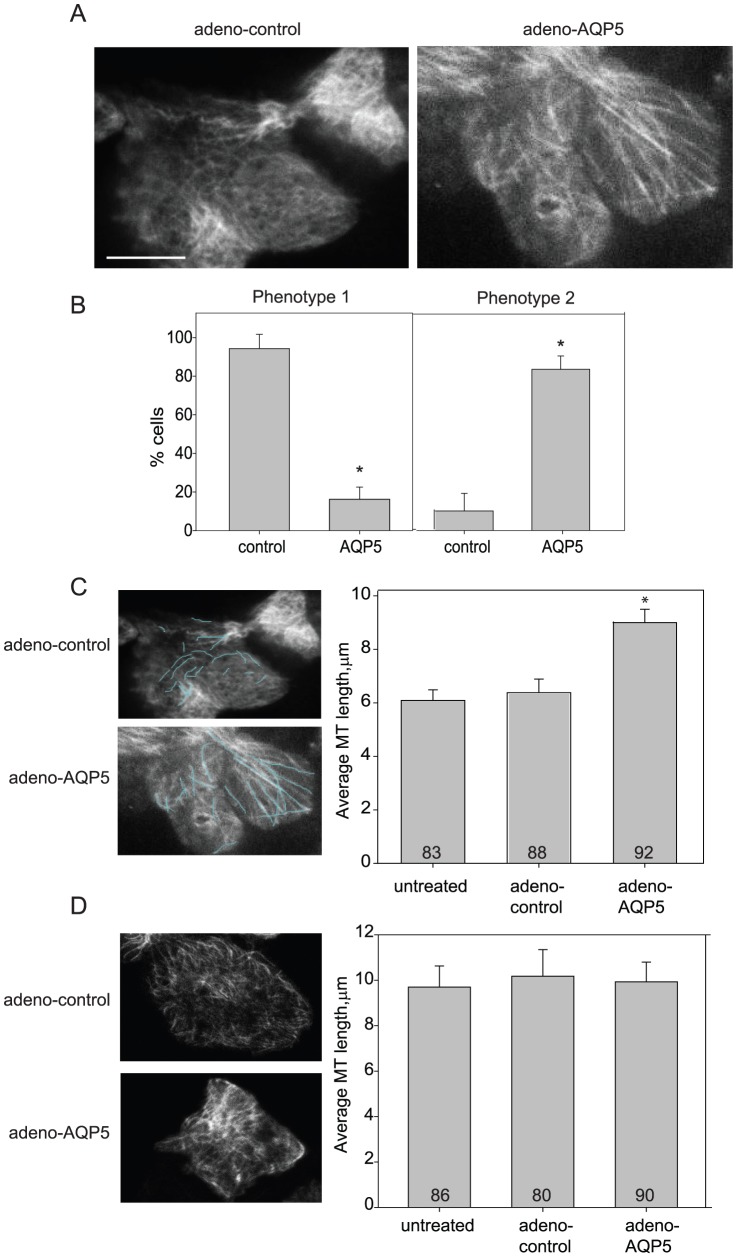
Total internal reflection fluorescence (TIRF) imaging showed that AQP5 altered MT structure at apical surfaces.A. Cells transduced with control adenoviruses (adeno-control) show a MT meshwork at their apical surfaces. Cells expressing AQP5 (adeno-AQP5) had longer, more aligned MTs at their apical surfaces. Scale bar, 10 µm. B. Cells expressing AQP5 were significantly more likely to have long and straight apical MTs. MT phenotypes were grouped into two categories, phenotype 1 (panel A, adeno control (n=22 cells) image is an example) and phenotype 2 (panel A, adeno-AQP5 (n=20 cells) image is an example). Cells within each treatment group were sorted based on image appearance. The frequency of cells that had either phenotype for each condition is plotted on the bar graphs. The two groups were significantly different (Comparison of Proportions (CP): z=4.6; p<0.0001). C. Cells expressing AQP5 had longer apical MTs than control cells had. Images show examples of individual traces MTs. Bar graph shows the average length per condition (ANOVA one-way: p=0.001). Using live TIRF, microtubules visualized on the apical surface were measured using ImageJ. 8–10 microtubules were measured per cell across 20–22 cells per treatment group. Total MTs analyzed is shown on the bar graph. D. Analysis of the basolateral surface showed no significant difference in MT length per condition. Bar graph shows the average length per condition with total number of MTs sampled depicted (8–10 cells per treatment group).